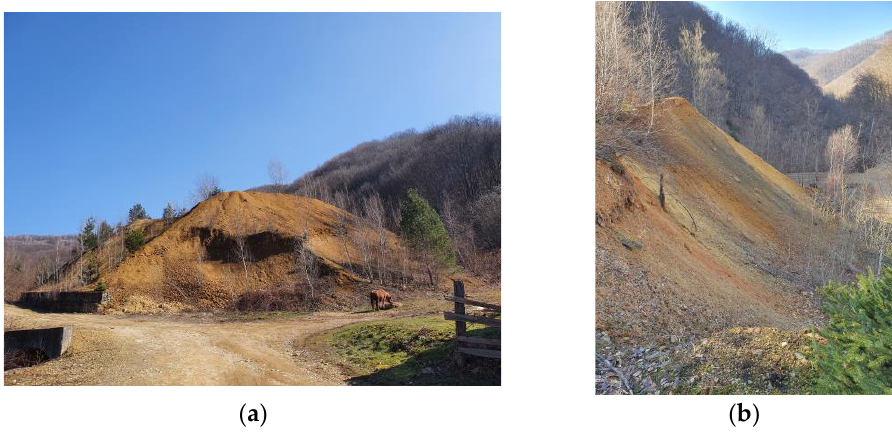
Figure 6. Sterile dumps, Ilba area, Romania (photos: I.A.P.): ( a ) Sterile dump in the vicinity of the households from which the material slid; ( b ) Sterile dump in the vicinity of